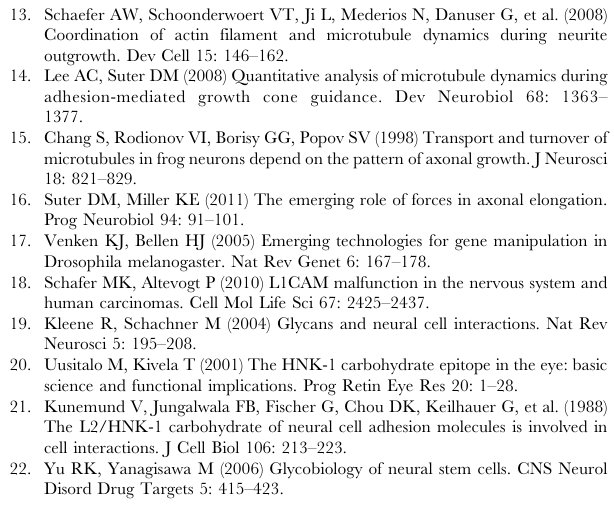
DNA (B) sequences from brv + , brv 1 , brv 2 , and brv 3 alleles are presented. The 14 bp long deletion in the brv 1 cDNA (boxed) is a consequence of a G to A mutation in the splice acceptor (black box) and the use of a cryptic alternative splice acceptor (red box). A G to A mutation transforms a Trp codon (TGG) to a Stop codon (TAG) (C, boxed) in brv 2 . A T to A transversion changes the conserved, non-polar, Leu residue (CTG) into the polar Gln amino acid (CAG) (D, boxed) in brv 3 . (E) Partial alignment of several GlcAT-P orthologs shows that the brv 3 mutation affects an evolutionarily conserved hydrophobic residue (boxed). Figure S2 (A) Protein preparations from brv + and Df(3L)GlcAT-P brains were blotted with anti-HNK-1 (HNK-1) and anti-GlcAT-S (GlcAT-S) antibodies. (B–C) Misexpression of UAS-GlcAT-P in L3 larva wing imaginal discs with Dpp blink -GAL4. (B) Ectopic expression of GlcAT-P is detected by a -GlcAT-P immunohisto- chemistry in the typical pattern of dpp expression domain. The white box indicates the region shown in (C). (C) Co-labeling (arrows) of a -GlcAT-P ( red) with Sqh::EYFP-Golgi (green) reveals that GlcAT-P protein is localized to the Golgi apparatus. Bars in B and C are 100 m m and 20 m m respectively. Figure S3 GlcAT-P-GAL4 driven expression of a reporter gene (nuclear b -Gal) recapitulates aspects of endogenous GlcAT-P expression during embryogenesis. (A, B) Note that reporter gene expression mimics the described GlcAT-P in situ hybridization expression pattern (see BDGP;http://www.fruitfly.org/cgi-bin/ ex/bquery.pl?qtype=report&find=CG6207&searchfield=CG). LacZ expression was detected in the amnioserosa (A; arrows) of stage 14 embryos, and in salivary glands (B; arrowheads) and the gut (arrows) at stage 17. Bar: 100 m m. Figure S4 The general structure the VNC is unaffected in brv mutant larvae. Labeling of L3 larva brains from wild-type ( brv + ) and brv 1 with anti-22C10 (A, B), anti-BP102 (C, D), anti-Fas2 (E, F), anti-Elav (G, H) and anti-Repo (I, J) shows apparently normal VNC structure in brv mutants. Bar: 50 m m. Figure S5 Mushroom body neurons and VUM motoneurons are apparently normal in brv mutants. (A, B) OK107-GAL4 . UAS-